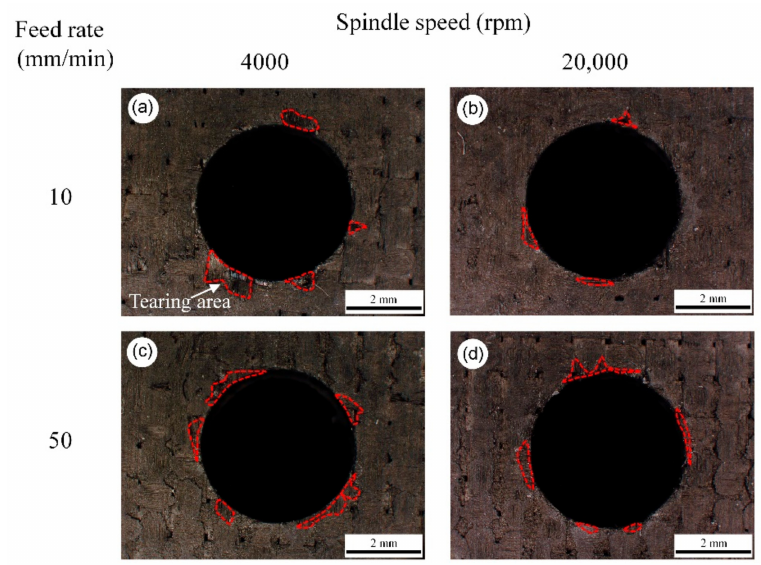
Figure 15. The morphology of the hole exit tearing areas in RUAD with ( a ) n = 4000 rpm, v w = 10 mm/min; ( b ) n = 20,000 rpm, v w = 10 mm/min; ( c ) n = 4000 rpm, v w = 50 mm/min; ( d ) n = 20,000 rpm, v w = 50 mm/min.